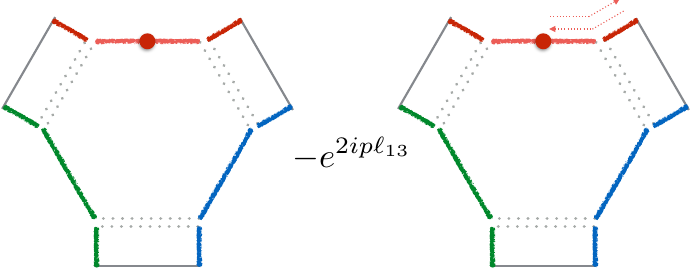
is given by the summation over the positions 123